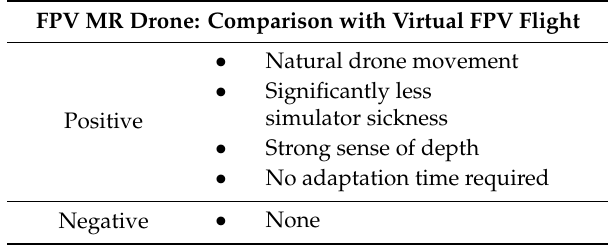
Table 3. Comparison of FPV control in virtual and mixed reality.